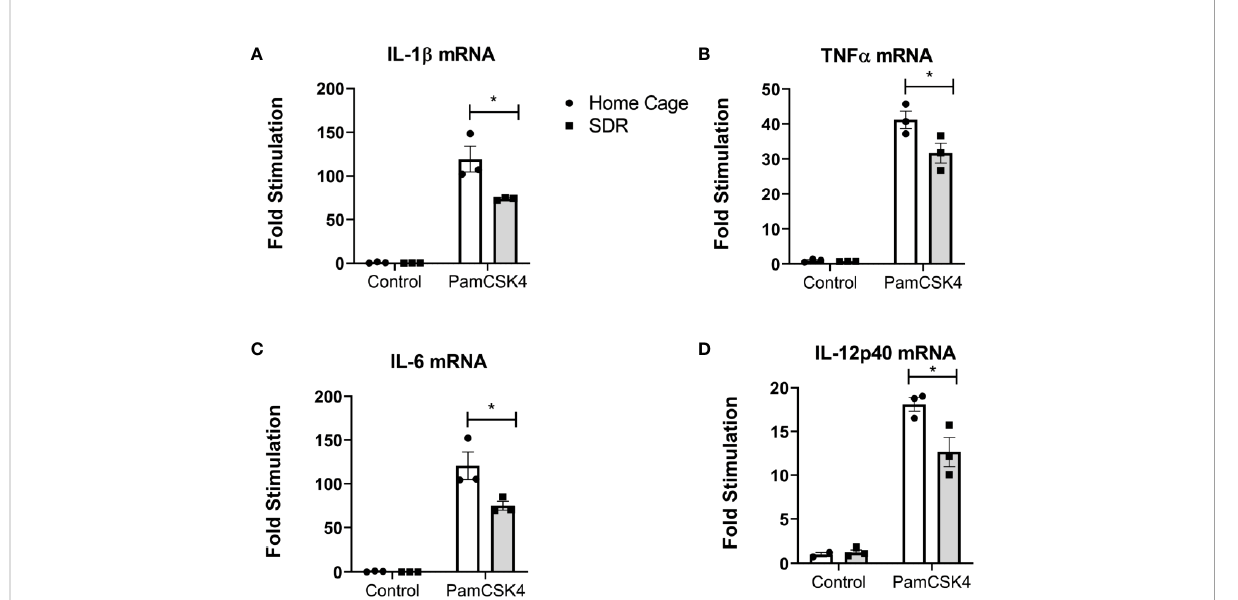
FIGURE 3 SDR suppresses TLR2 induced pro-in fl ammatory cytokine mRNA levels in AMs from old mice. AMs were pooled from six old Home Cage and six SDR mice were cultured at 37° for 2 hrs. Nonadherent cells were removed by washing and adherent cells stimulated with TLR2 ligand Pam 3 CSK 4 (100 ng/ml) for 6 hrs. RNA was isolated and cytokine mRNA levels determined by qRT-PCR. (A-D) RNA levels are expressed relative to b -actin mRNA levels. Results are representative of two independent experiments with 3 wells/treatment. Data are shown as mean ± SE. Statistical analysis was performed by one-way ANOVA with Tukey multiple-comparisons post hoc test. * p <